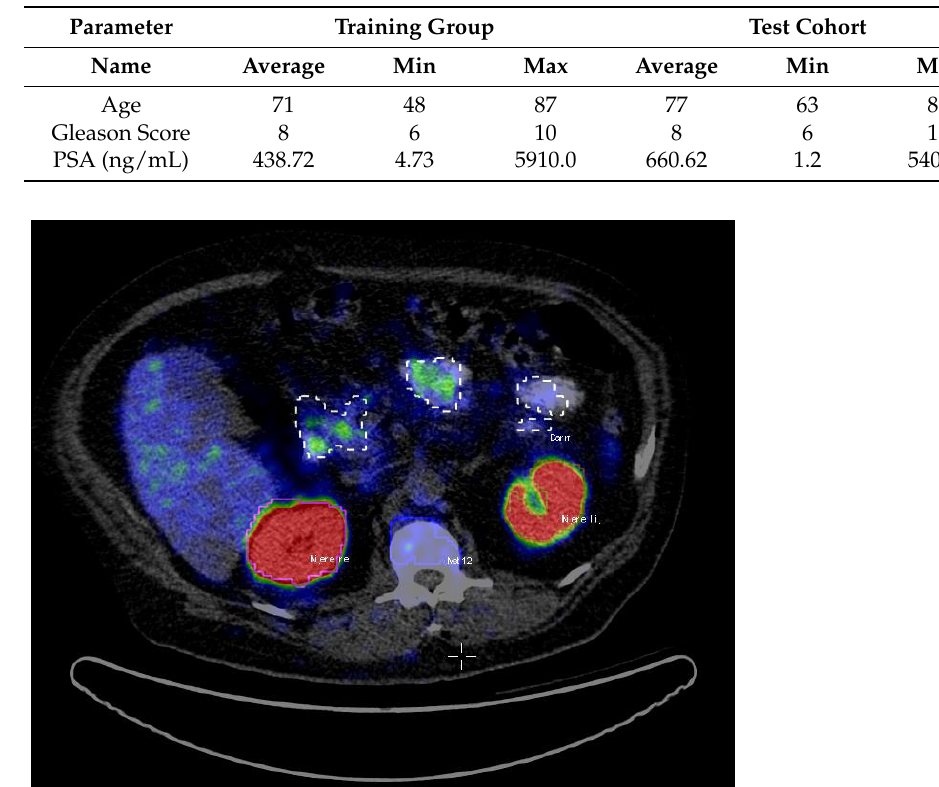
Table 1. The age, Gleason score, and PSA level ranges for the patients in the training and test cohorts.